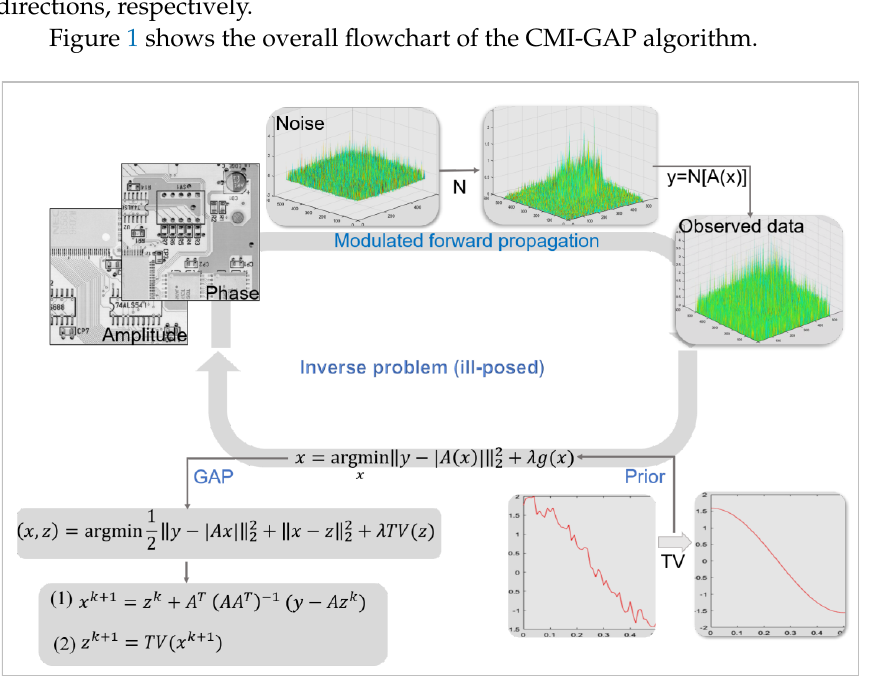
Figure 1. The flowchart of the proposed CMI-GAP algorithm. It consists of two parts, forward propagation via CMI and inverse propagation via GAP. The introduction of TV regularization helps improve the performance under low lighting conditions.